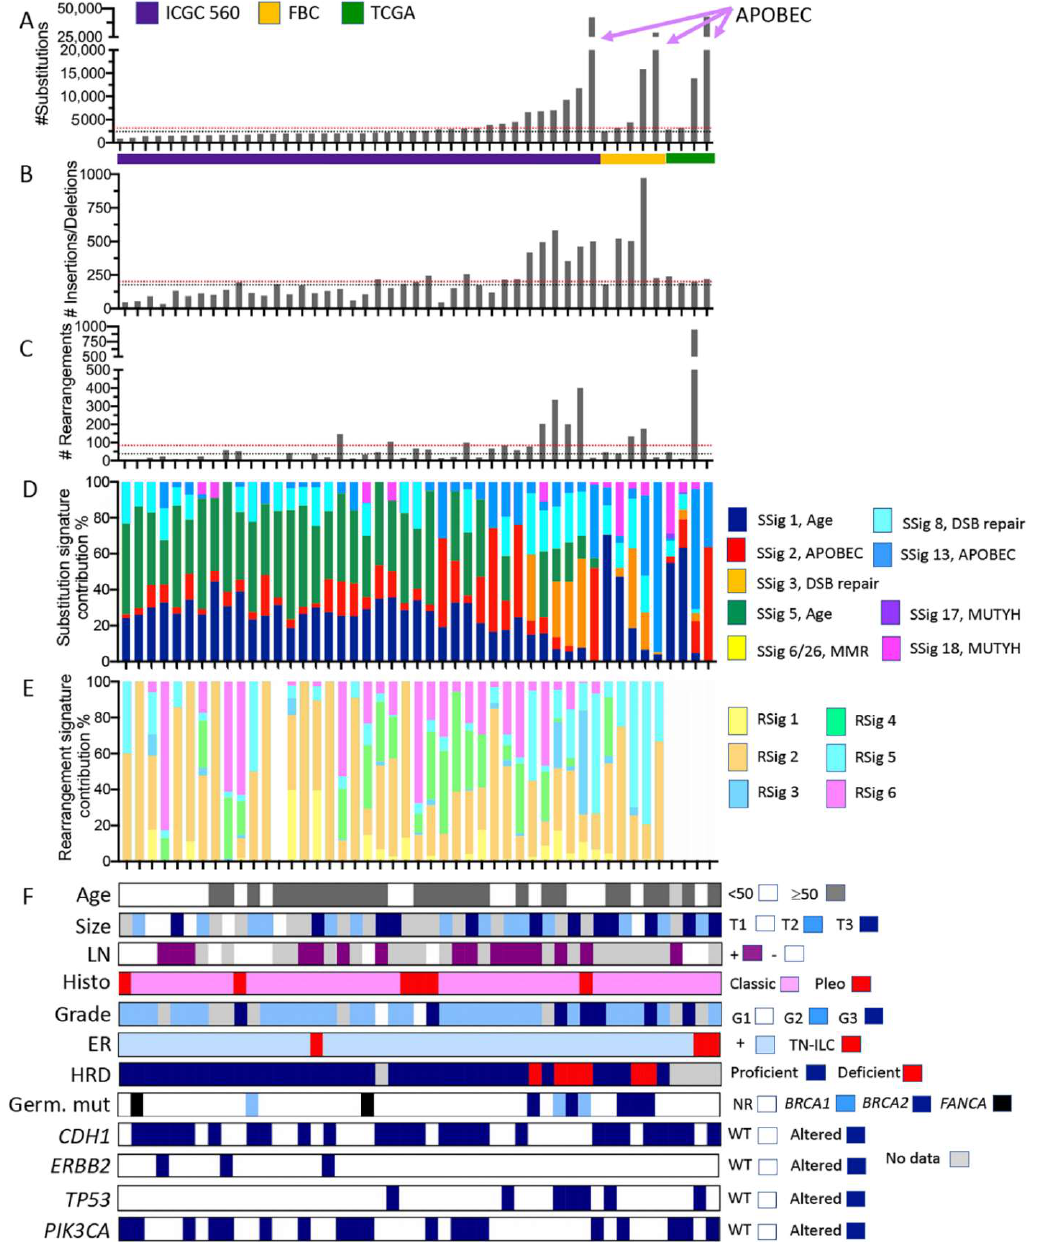
Figure 3. Somatic mutation characteristics of ILC derived from whole genome sequencing data. Individual tumours from three cohort studies are organised in each plot on the x -axis according to increasing numbers of somatic substitution mutations ( y -axis in A ). Plots ( B , C ) show the numbers of small insertions/deletions and large rearrangements, respectively. ICGC 560 overall cohort medians for the numbers of substitutions, insertions/deletions, and rearrangements are depicted by the red dotted lines in ( A – C ); similarly, the medians for the ILC in this pooled cohort are depicted by the black dotted line. Plots ( D , E ) show how the proportion of substitutions (from A ) and rearrangements (from C ) were assigned to substitution mutational signatures (SSig) or rearrangement signatures (RSig), respectively. Note that rearrangement signatures for ILC from the TCGA cohort were not calculated. ( F ) Clinicopathological features and mutation of key cancer driver genes. Abbreviations: DSB repair = double strand break repair; FBC = familial breast cancer cohort; G1, G2, G3 = grade 1, 2, or 3, respectively; Germ. Mut = germline pathogenic mutation; HRD = Homologous recombination deficiency, as defined by HRDetect [28] (proficient = functional HR-based DNA repair; deficient = non-functional HR-based DNA repair); MMR = mismatch repair; LN = lymph node; NR = not recorded; Pleo = pleomorphic; RSig = rearrangement signature; SSig = substitution signature; T1, T2, T3 = tumour size; and WT = wild type. Colour coding is described in the associated legends for each